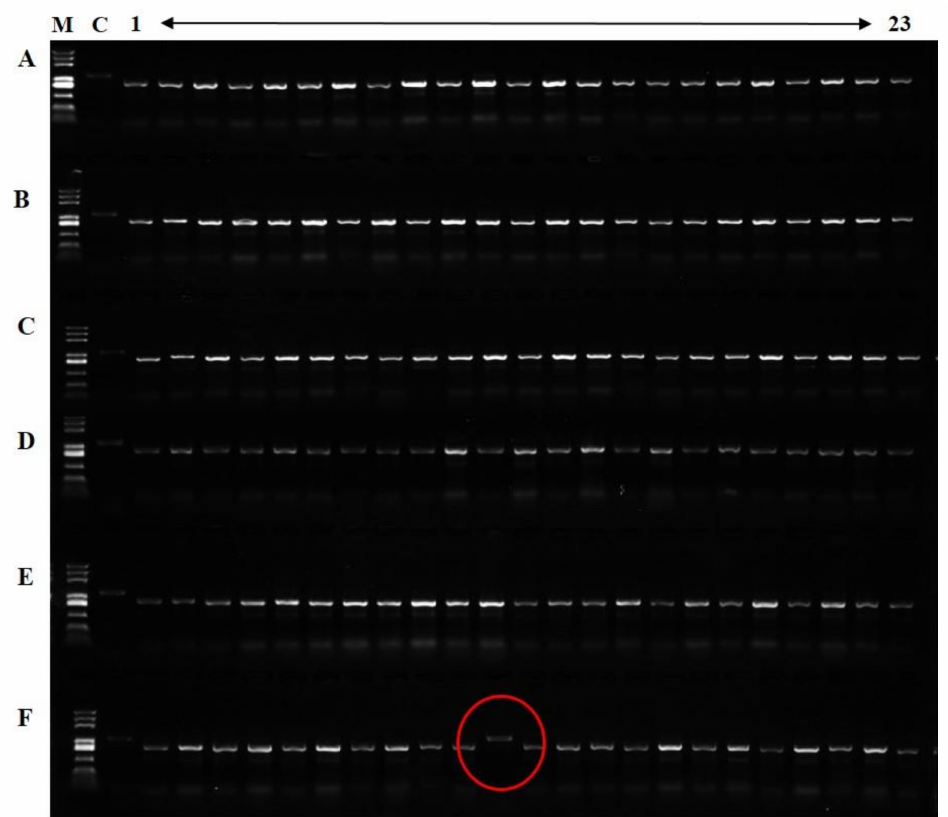
Figure 4. Detection of 138 cabbage lines by using MBoHL1. C, positive control, the amplified bands of 09-211. F11 (cabbage line G94) exhibited the same bands as the positive control (The red